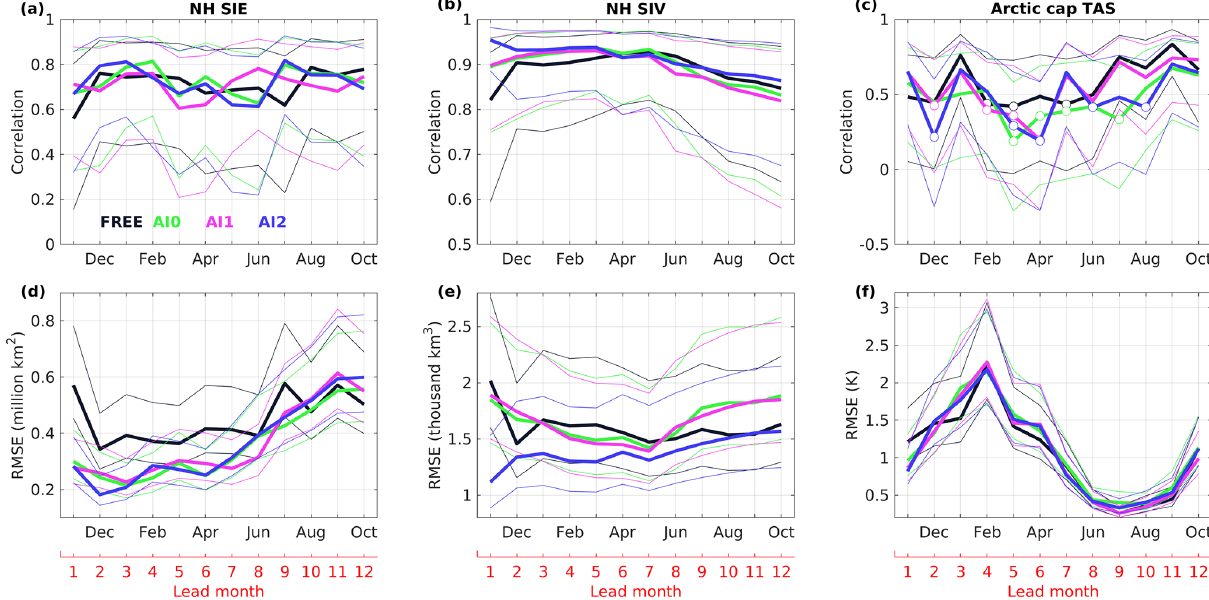
Figure 7. Correlation (a–c) and root mean square error (RMSE, d–f ) for the NH SIE (millionkm 2 ), SIV (thousandkm 3 ) and TAS (K) over the polar cap domain, against REF for the first 12-month forecasts started on 1 November from 1996 to 2015. It is calculated for each lead time with respect to its monthly climatology. The thin lines represent the 95% confidence intervals obtained with a t distribution for the correlation and a χ 2 distribution for the RMSE. Open circles are used if not significant ( p = 0 . 05). Note that the y axis has different